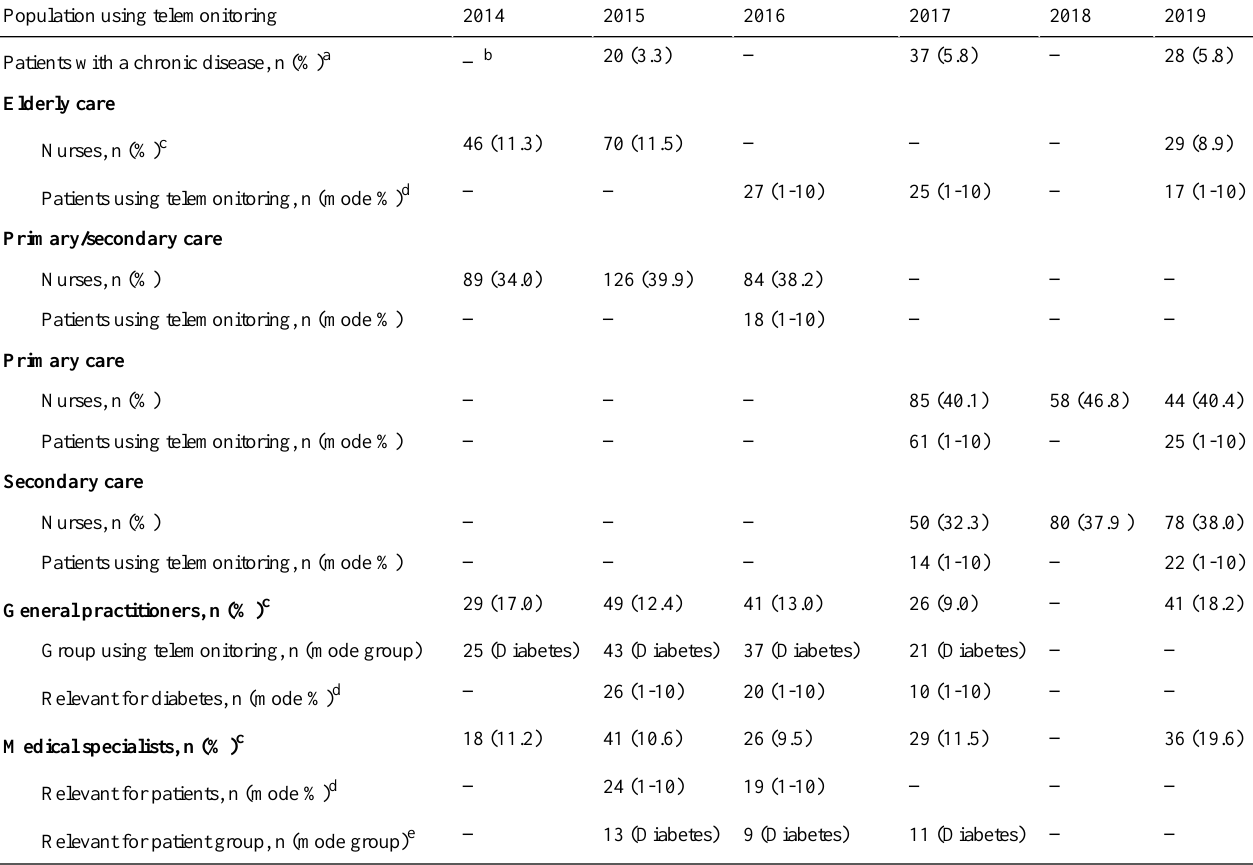
Table 2. Proportions of patients and health care professionals (HCPs) using telemonitoring, from 2014 to 2019. 201920182017201620152014Population using